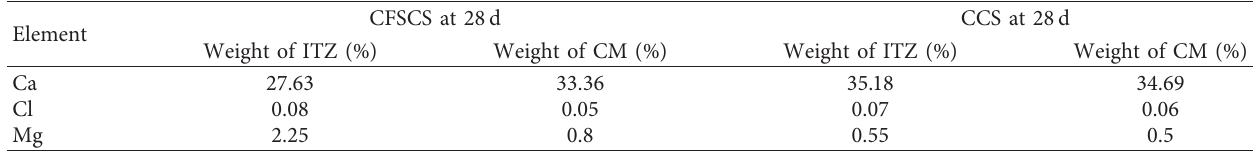
Table 7: EDS analysis of mortar samples at